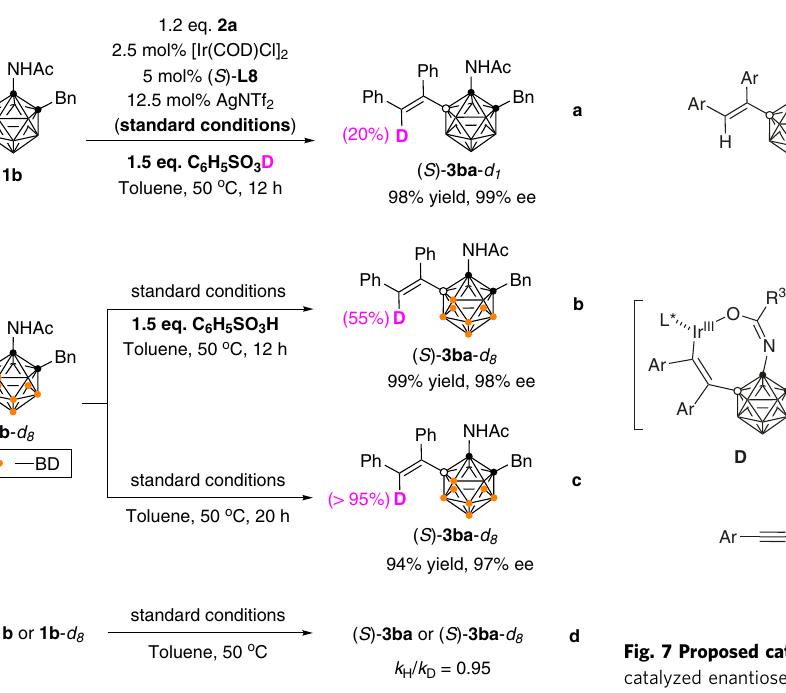
Fig. 6 Mechanistic investigations. Control experiments. a Reaction of 1b using C 6 H 5 SO 3 D as the acid additive. b Reaction of 1b - d 8 using C 6 H 5 SO 3 H as the acid additive. c Reaction of 1b without acid additive. d Independent- rate KIE experiments.